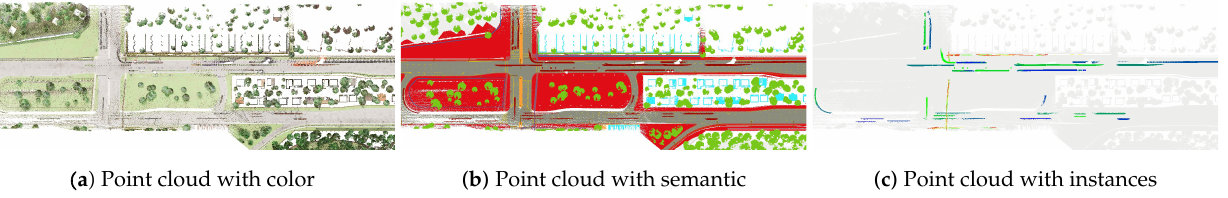
Figure A5. CARLA Validation set . T 6 (synthetic data). Figure A5. CARLA validation set. T 6 (synthetic